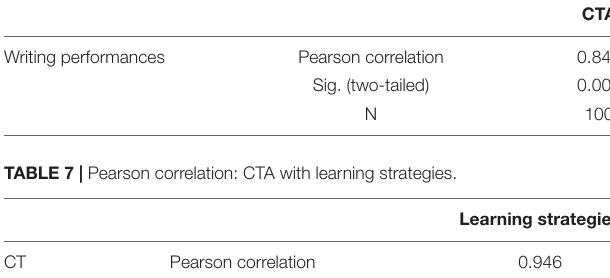
TABLE 4 | Pearson correlation: Learning strategies with writing performances.